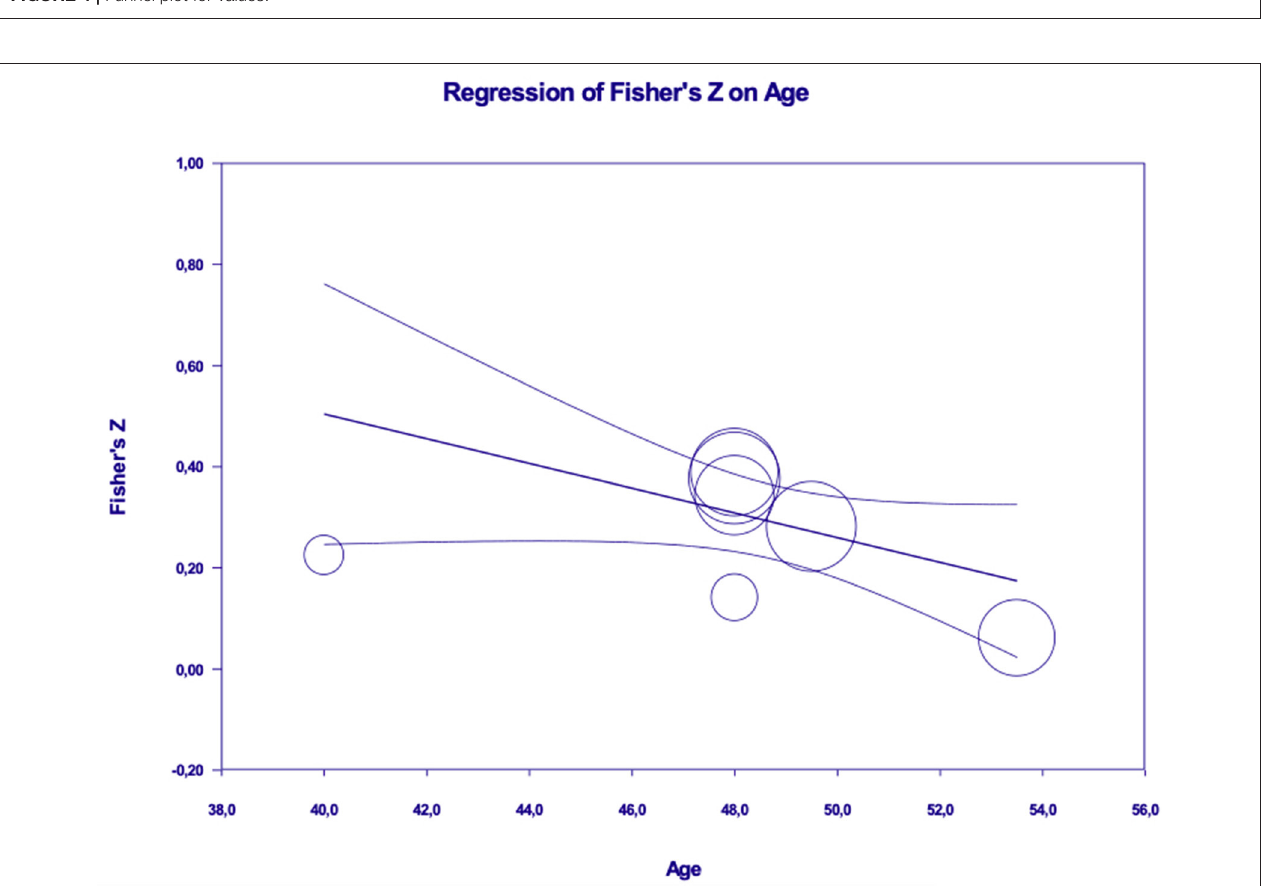
FIGURE 5 | Moderation effect of age in the relation between values and energy saving behaviors (or intentions).